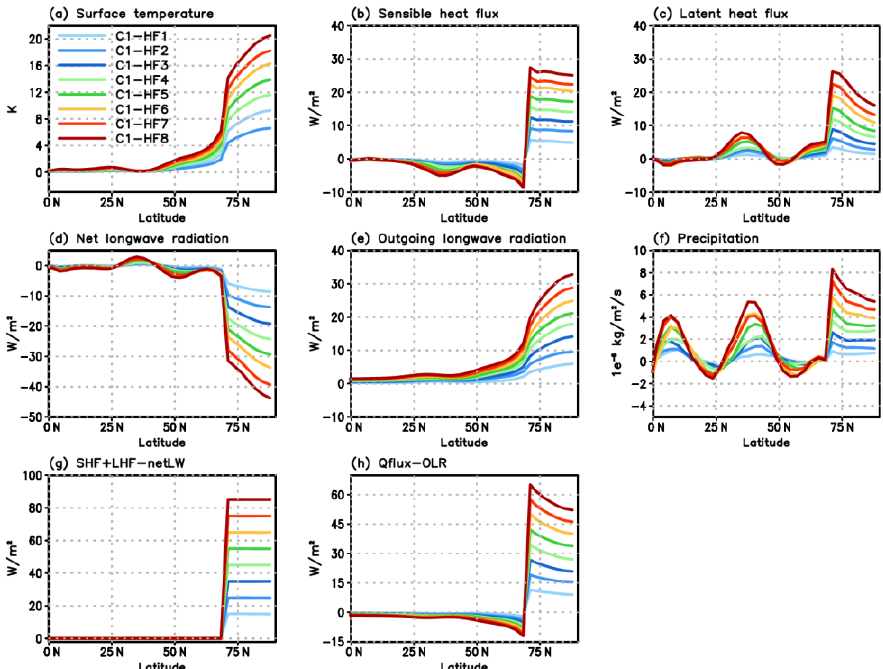
Figure 2. Time-mean zonally averaged deviation from CTRL ( a ) surface temperature, ( b ) sensible heat flux, ( c ) latent heat flux, ( d ) net downward longwave radiation, ( e ) outgoing longwave radiation, ( f ) precipitation, ( g ) surface energy balance, ( h ) difference between surface thermal forcing and outgoing longwave radiation.